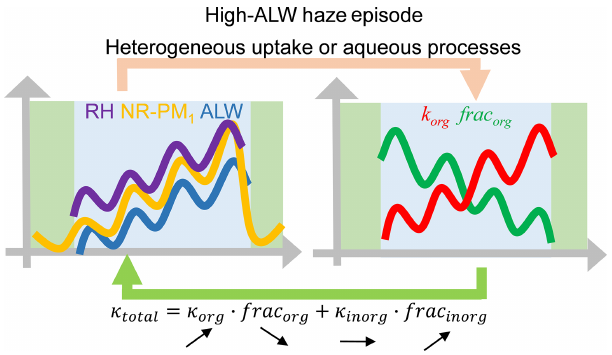
Figure 7. The positive feedback loops between aerosol liquid water and organic evolution during high-ALW haze episodes in Beijing.